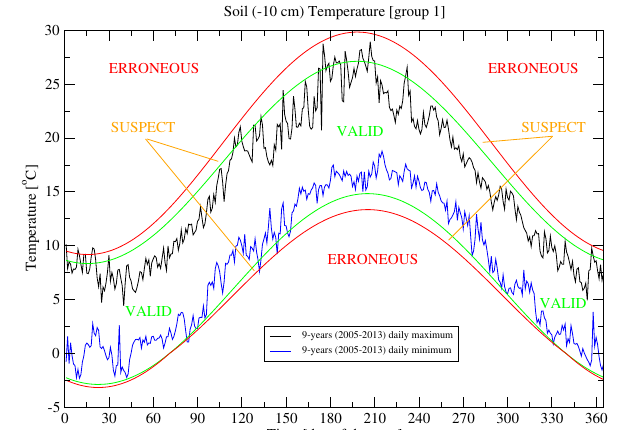
Figure 4. Probable bare soil–grass temperature differences as a function of the bare soil